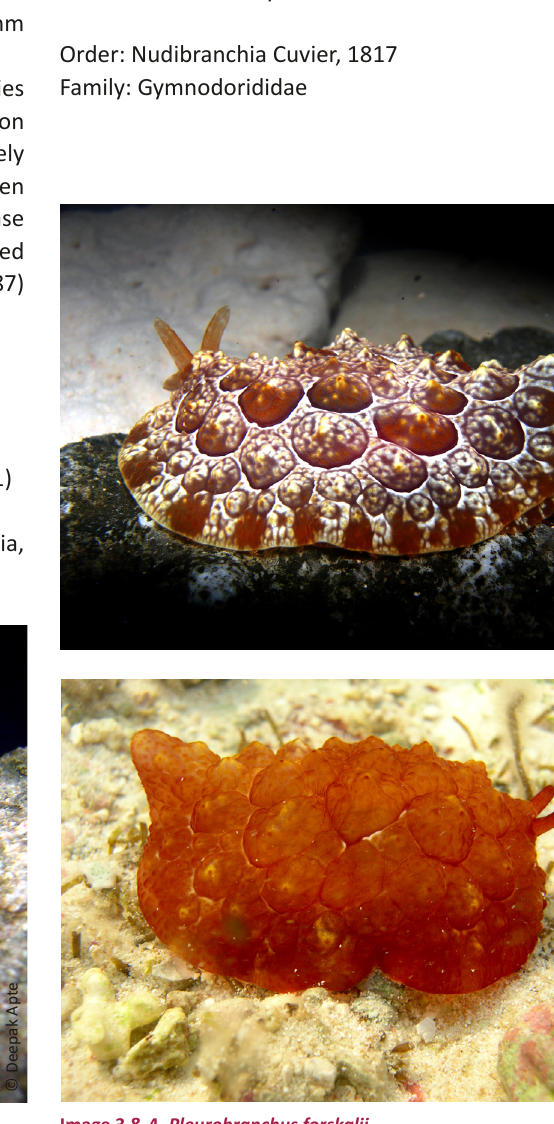
Image 2. Elysia rufescens Image 3 & 4. Pleurobranchus